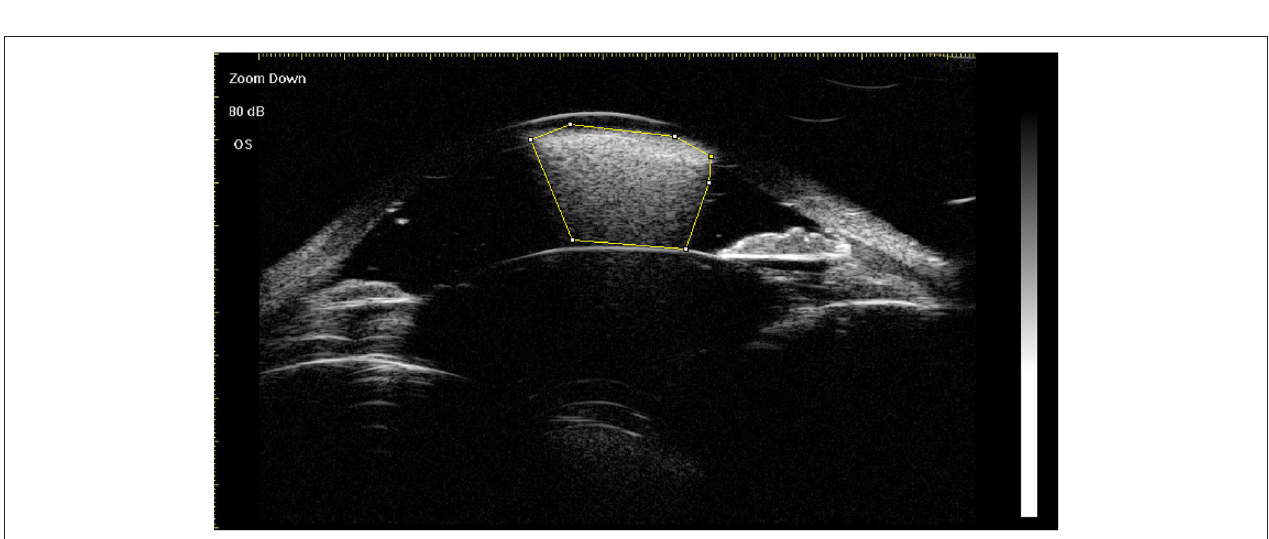
FIGURE 2 | Measurement of the area of hyperoleon (indicated with the yellow border) in the anterior chamber using ImageJ software.